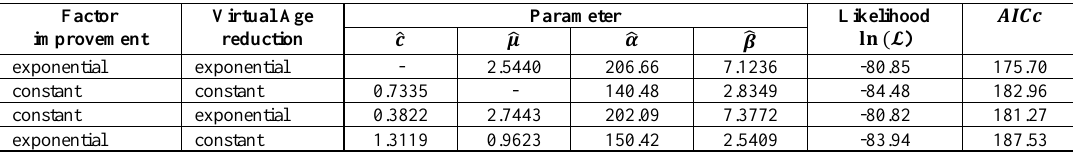
Table 4. Estimations of 𝜇 , 𝑐 , 𝛼 , 𝛽 , ln (ℒ) and 𝐴𝐼𝐶𝑐 from 𝐴𝑀𝐶